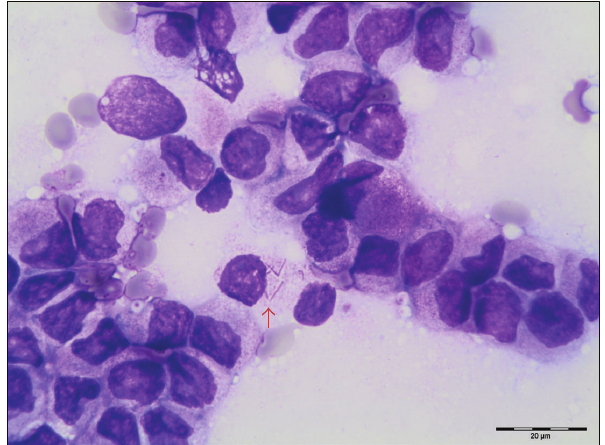
Figure 2: Wright-Giemsa stained touch imprint showing promye- locytes with fine azurophilic granules. Arrow: a myeloblast with multiple thin Auer rods typical of